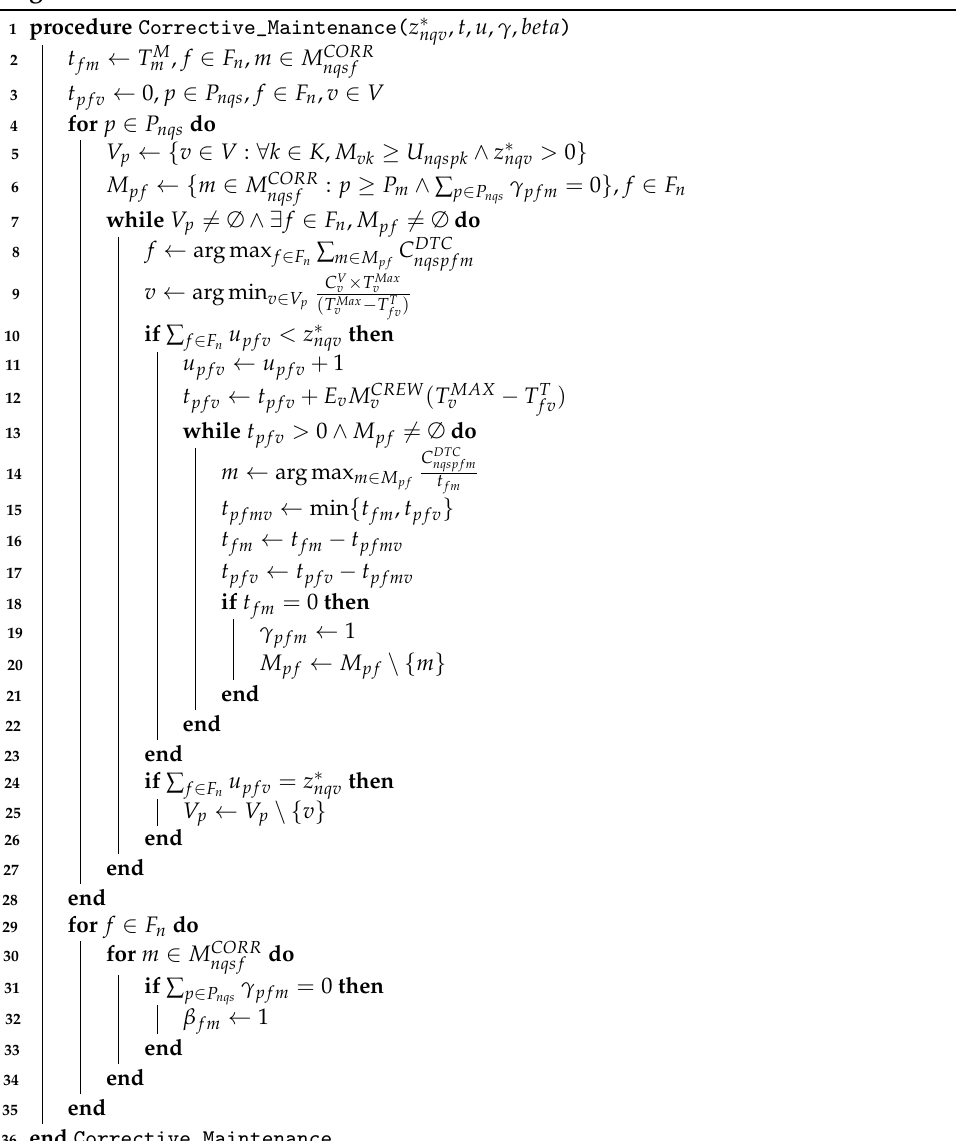
Algorithm 3: Corrective